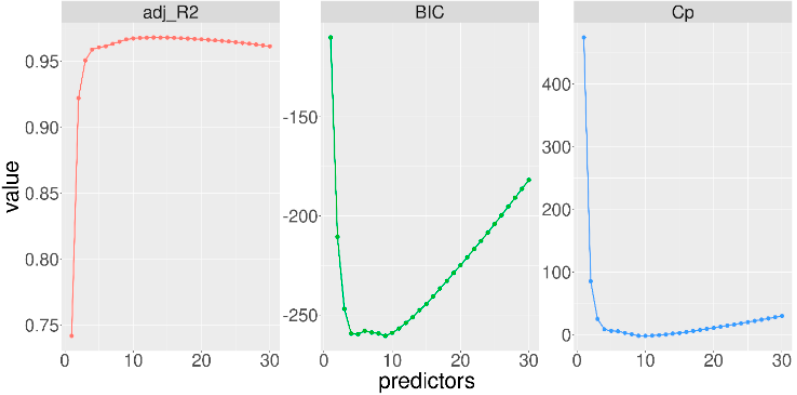
Figure 9. The linear model selection at the VT stage. Moreover, the mean CV error confirmed that the same number of variables were needed for the final model (Figure 10). As a result, the best subset selection on the full dataset with the lowest mean square error (MSE) was the 3-variable model used to predict grain yield at the VT stage.